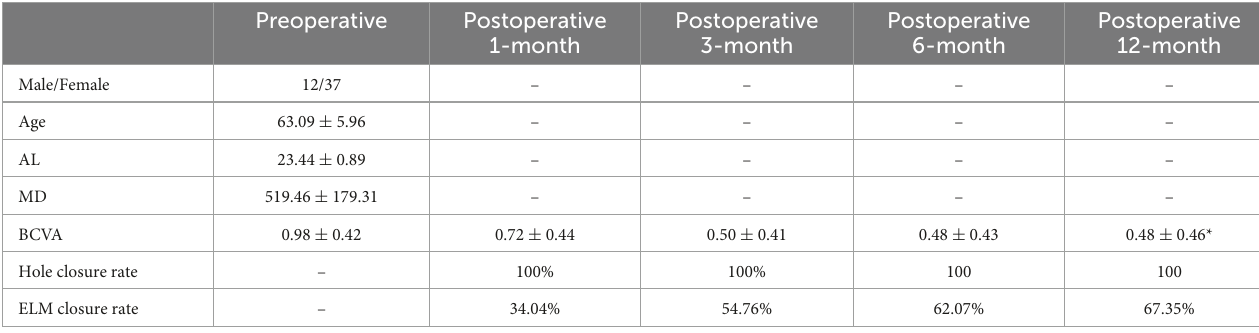
TABLE 1 The common material for 49 iMH patients.